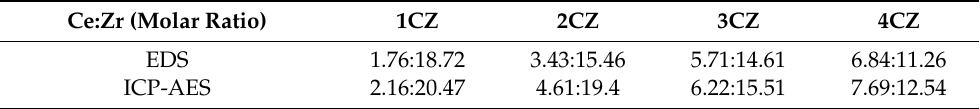
Table 2. Composition analyses of the obtained CZ